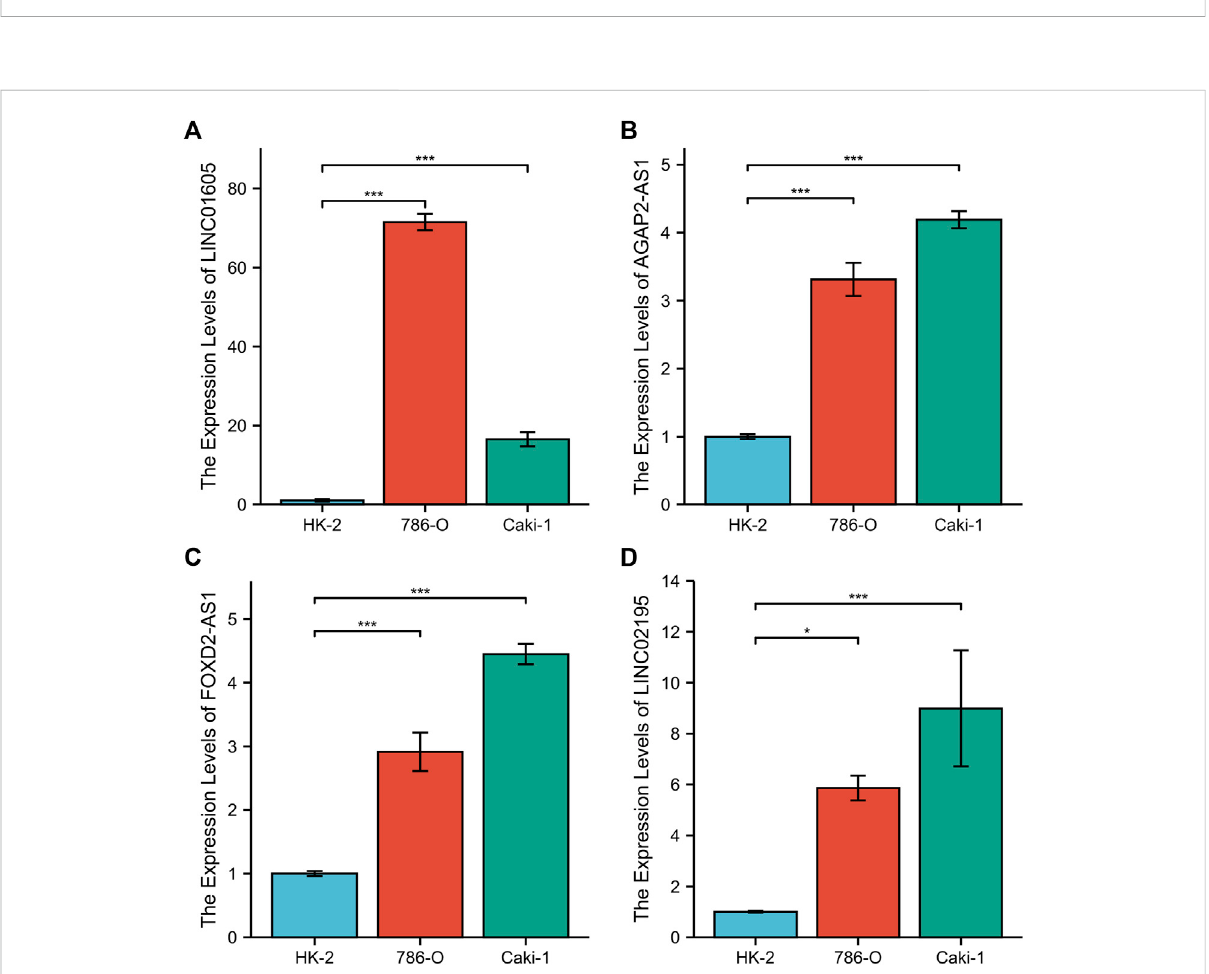
FIGURE 14 RT-qPCR of the four hub lncRNAs. (A) LINC01605, (B) AGAP2-AS1, (C) FOXD2-AS1, and (D)